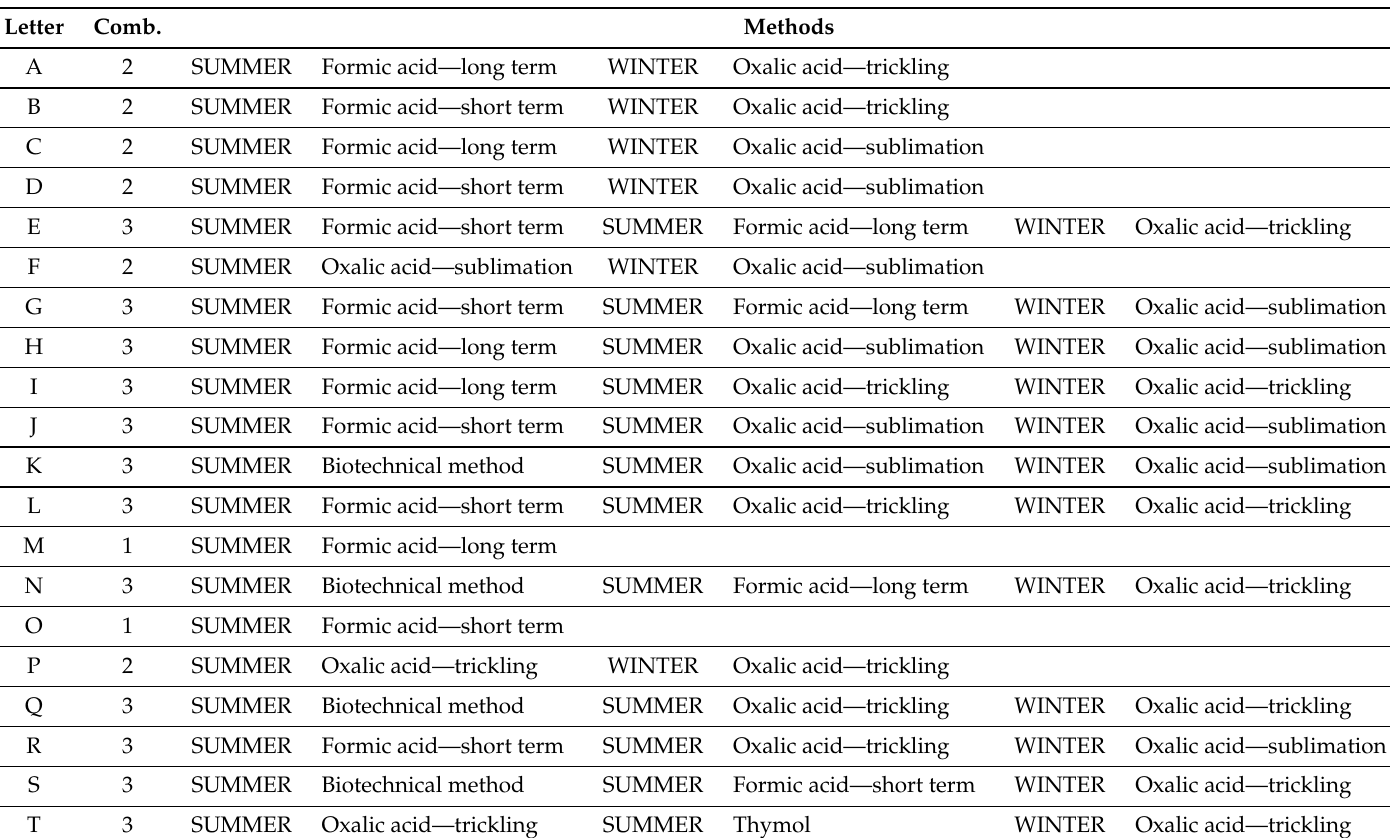
Table 2. This table shows the 20 most used combinations of treatment methods in the survey ( n > 14), ordered by number of participants using the combination from highest to lowest for summer (June–October) and Winter